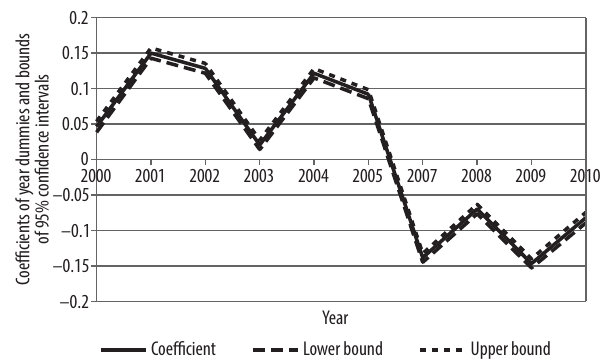
Fig. 3. Evolution of coefficients of the year